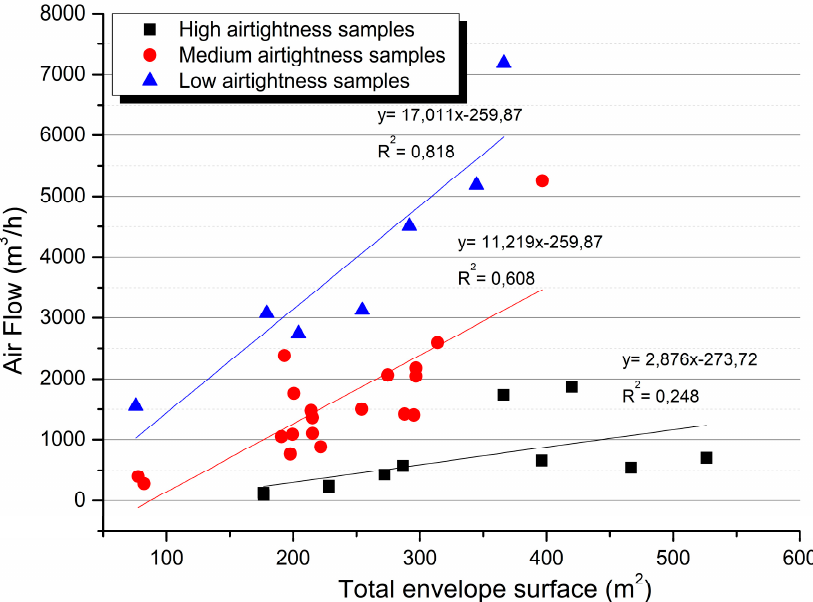
Figure 9. Correlation between airflow and envelope surface of the tested enclosures, according to the identified airtightness levels.